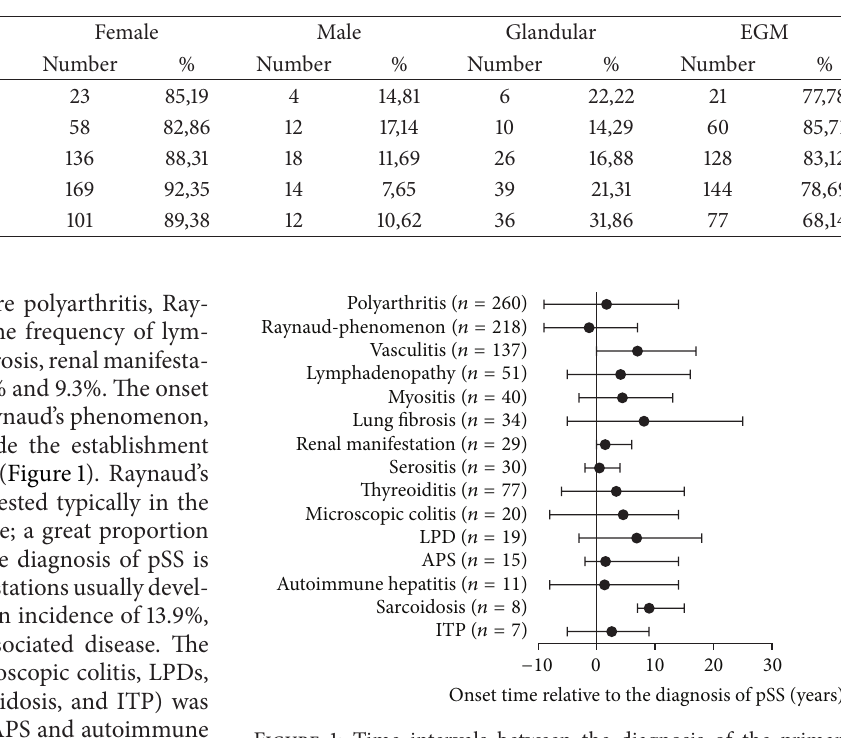
Figure 1: Time intervals between the diagnosis of the primary Sj¨ogren’s syndrome and the onset of extraglandular manifestations and associated